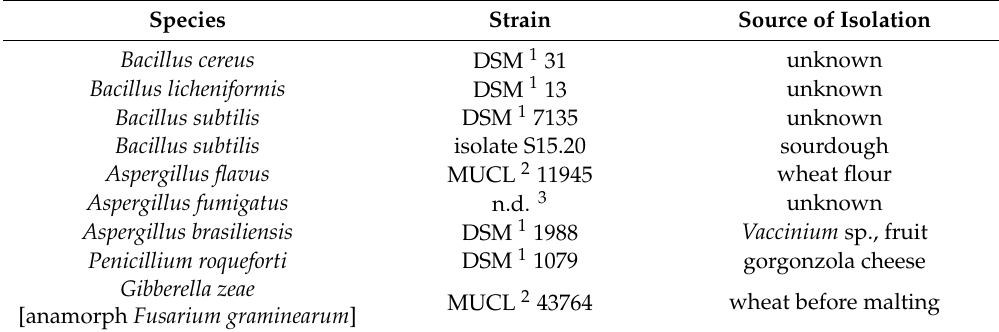
Table 1. Information of strains used for the determination of antifungal and antibacillus activity. Species Strain Source of